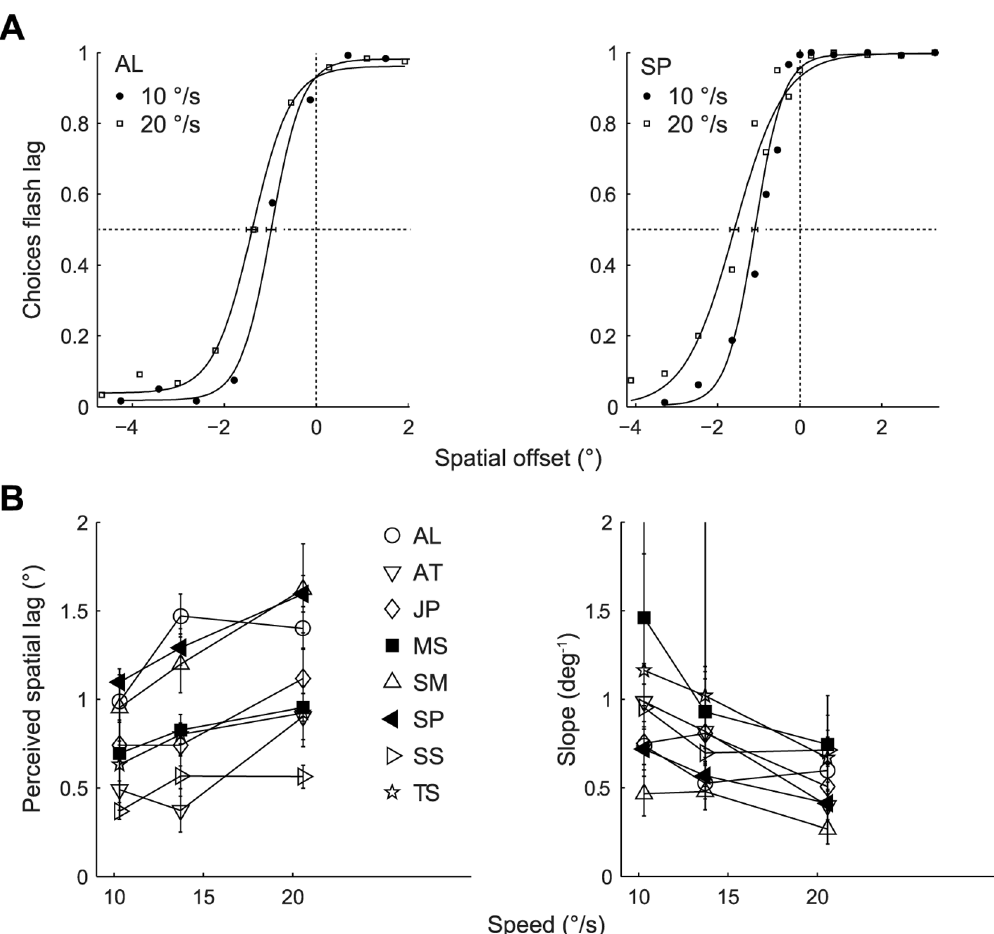
Figure 3. Flash lag illusion in humans. (A) Example psychometric functions from a naı¨ve (left panel) and a non-naı¨ve (right panel) human subject measured at two speeds of the moving bar. Each data point shown was computed from 120 (subject AL) or 126 (subject SP) trials pooled from three to four sessions. Error bars: 95% bootstrap percentile-based plug-in estimate of confidence intervals.(B) Perceived spatial lags (left panel) and slopes (right panel) of the psychometric function measured at different speeds of the moving bar from eight human subjects. Each data point represents the relevant parameter extracted from psychometric functions fitted (as in panel A) on responses pooled across two to five sessions. Open symbols: naı¨ve subjects; filled symbols: non-naı¨ve subjects. Error bars as in A. Slope error bar upper limits for subject TS are cropped: values are 6.5 and 6.1 for speeds 10 and 14 u /s respectively). doi:10.1371/journal.pone.0058788.g003 effect of species, F(1, 13.9) =0.0, p= 0.997; non-significant species